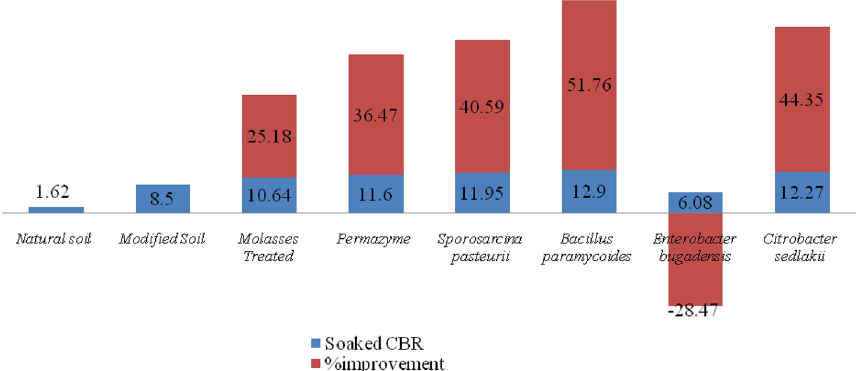
Fig. 3 CBR values of bioenzyme treated, 14 days cured and untreated soil